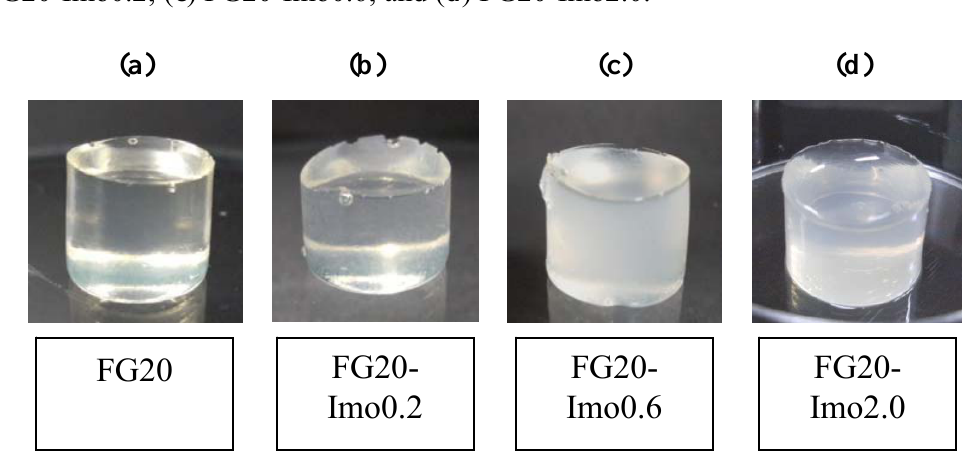
Figure 2. Digital photographs of composite hydrogels of FG and imogolite: ( a )